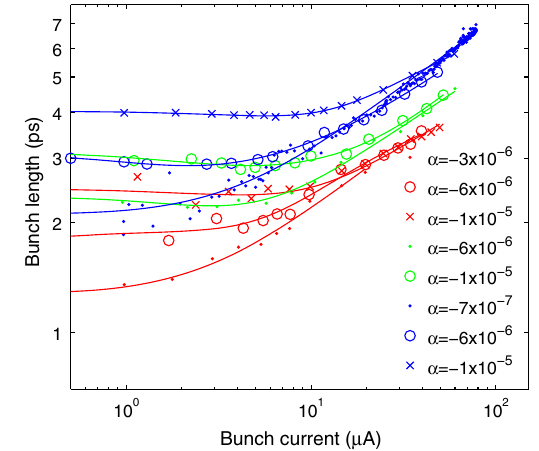
FIG. 7. Bunch length as a function of current under a variety of conditions. Data in red was measured at 3.4 MV, data in green was measured at 2.2 MV, and data in blue was measured at 1.5 MV, all using the low-emittance lattice.